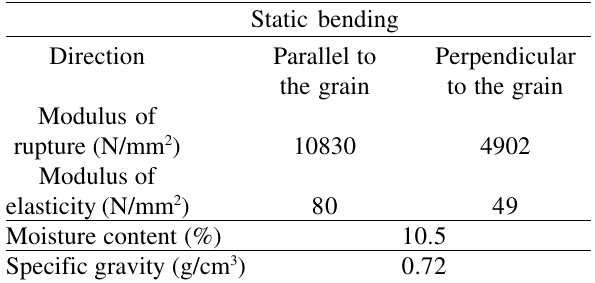
Table 6. Mean values of physical and mechanical properties for ply- wood made of Eucalyptus grandis and phenol-formaldehyde